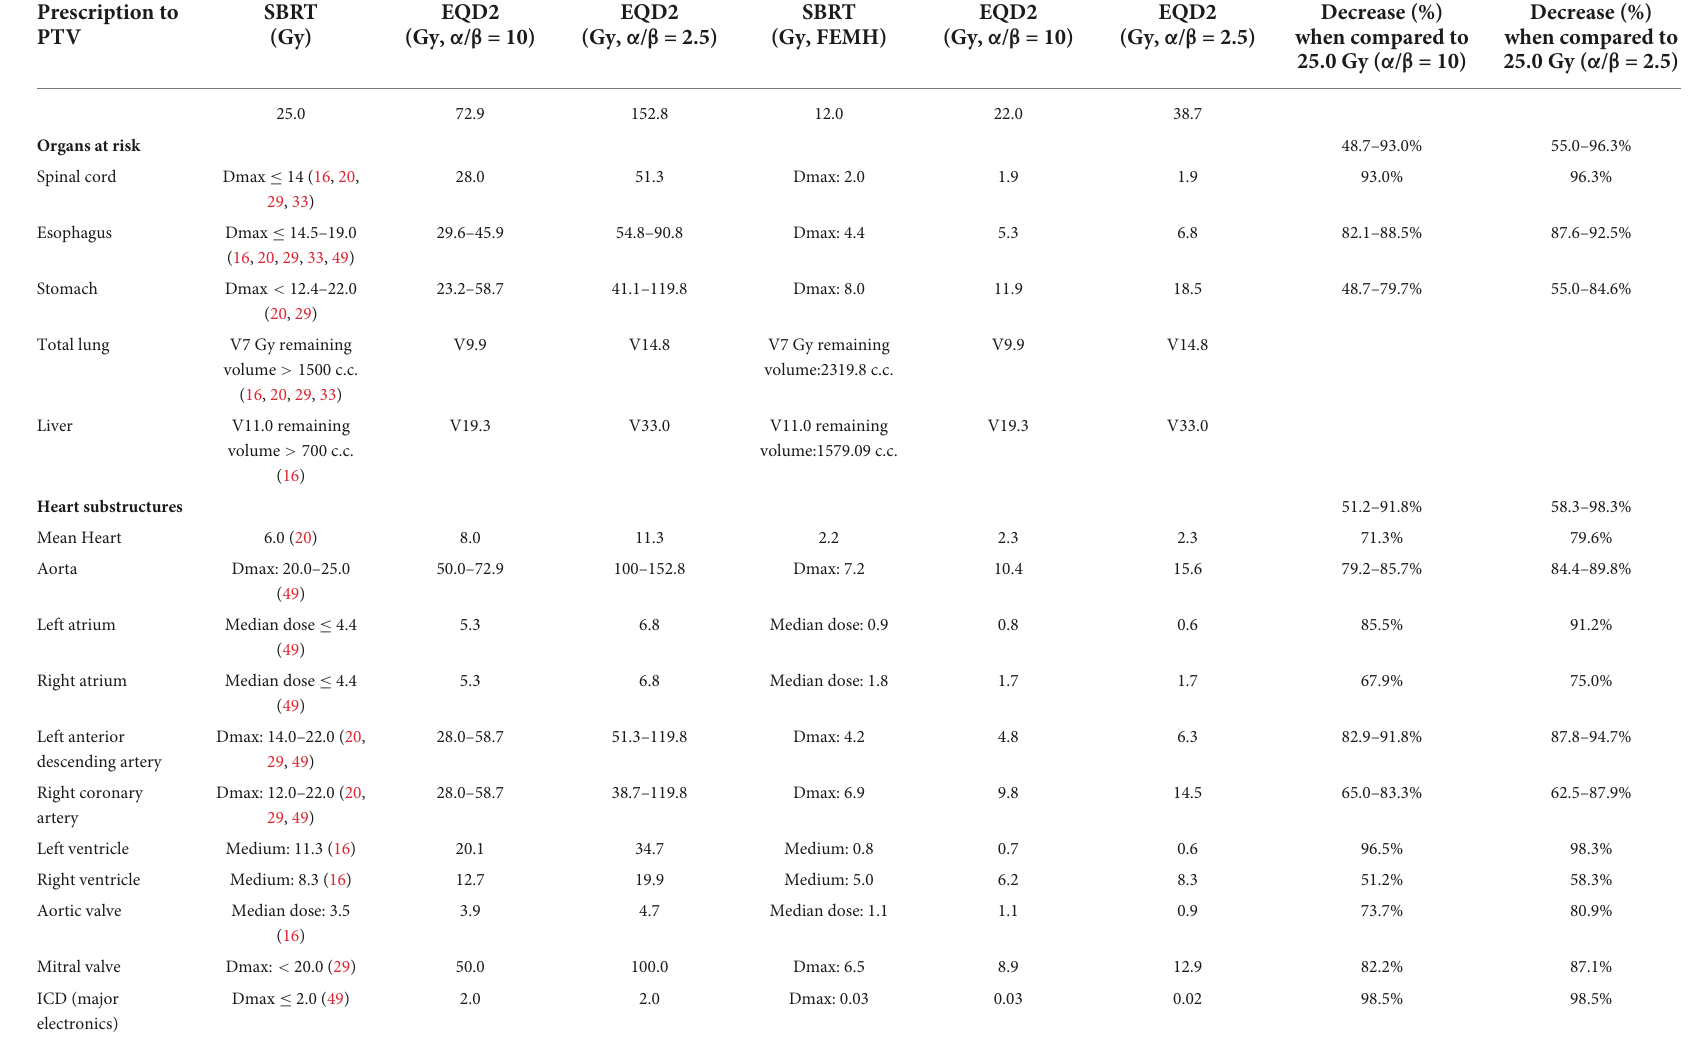
TABLE 1 The calculated doses to organs at risk and heart substructures for patients treated with stereotactic body radiation therapy (SBRT) 12 Gy. Prescription to